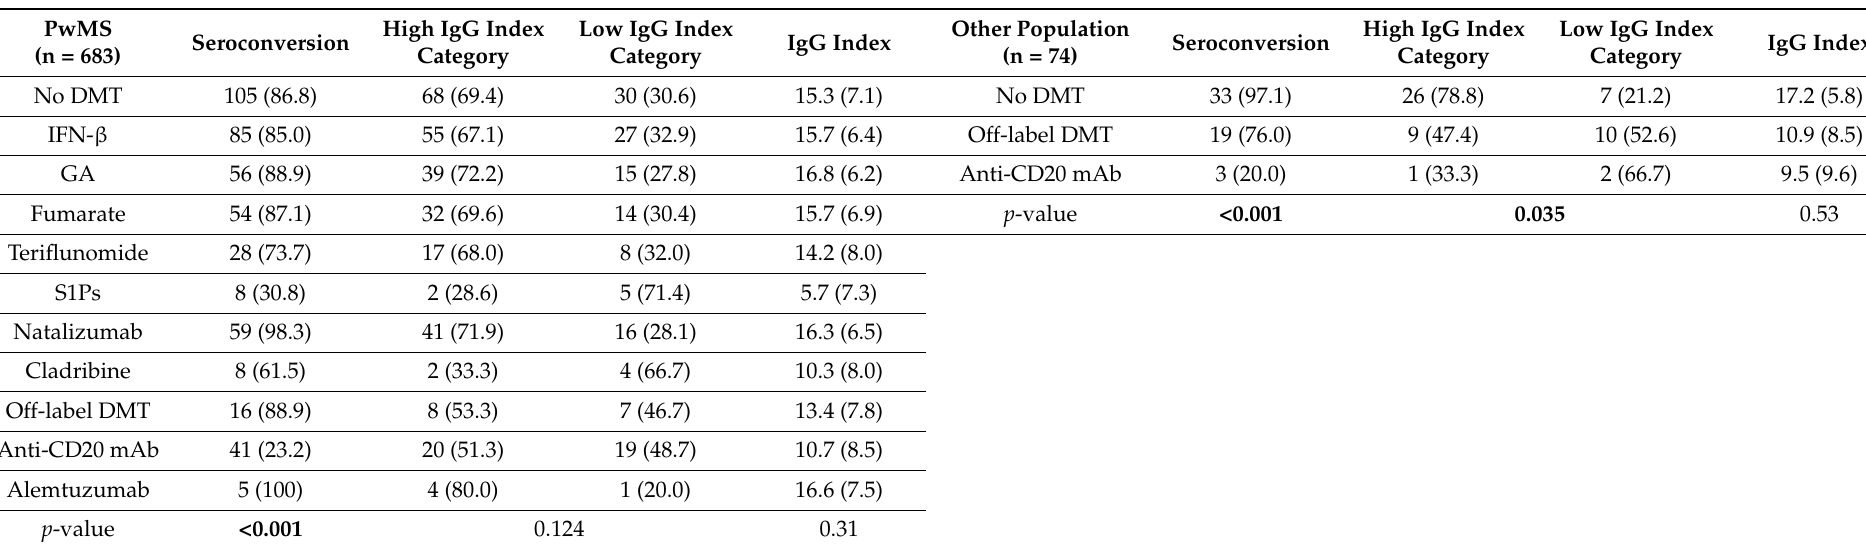
Table 2. Seroconversion after COVID-19 vaccination based on disease modifying